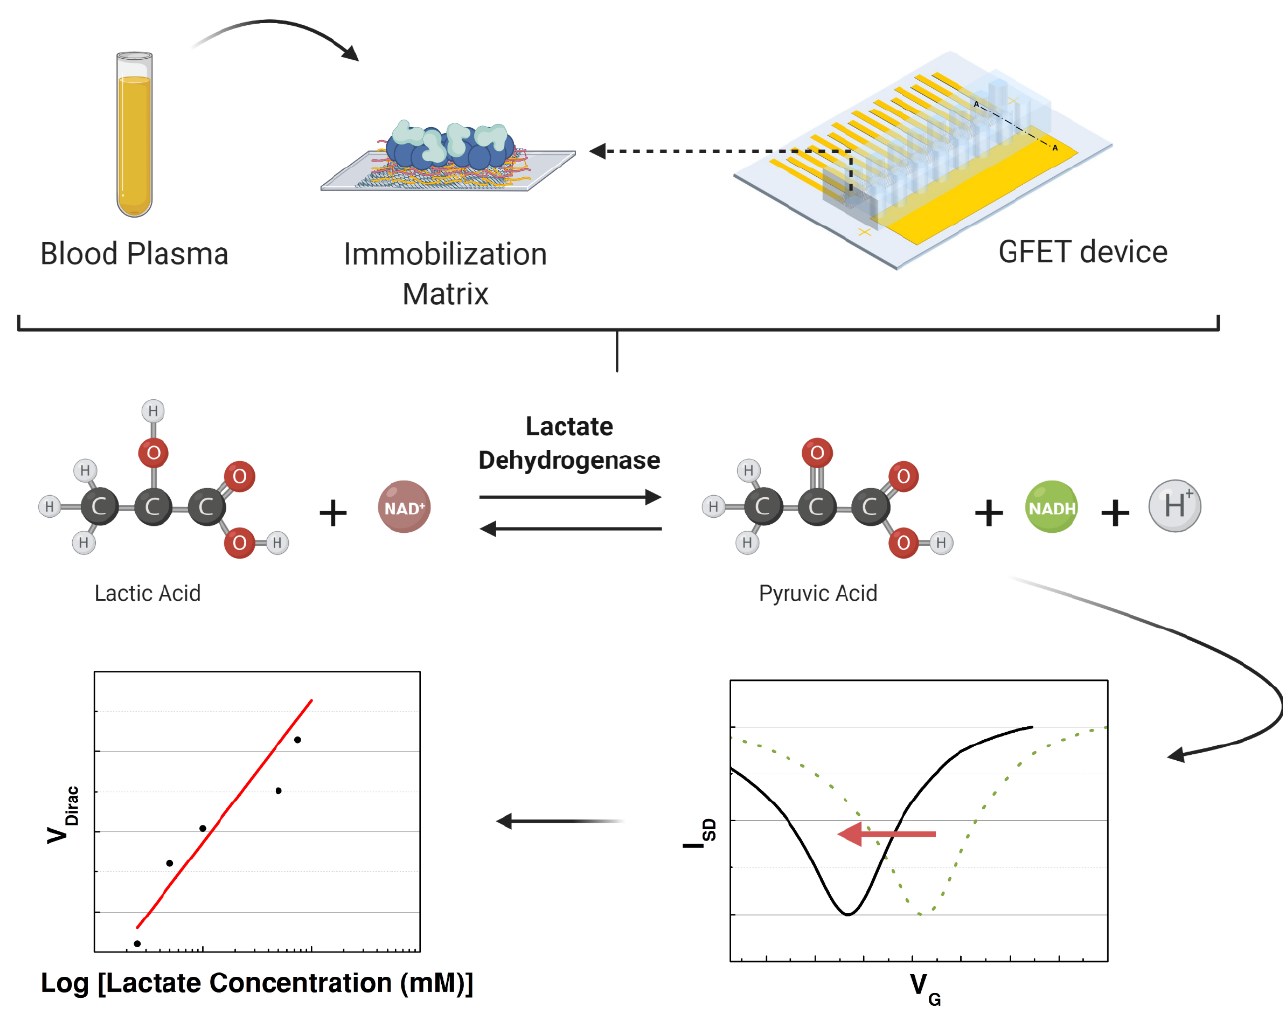
Figure 3. Schematic of the study performed to detect the concentration of lactate in the samples that were injected in the microchannels over the immobilization matrix while measuring the transfer characteristics of the graphene-based device .